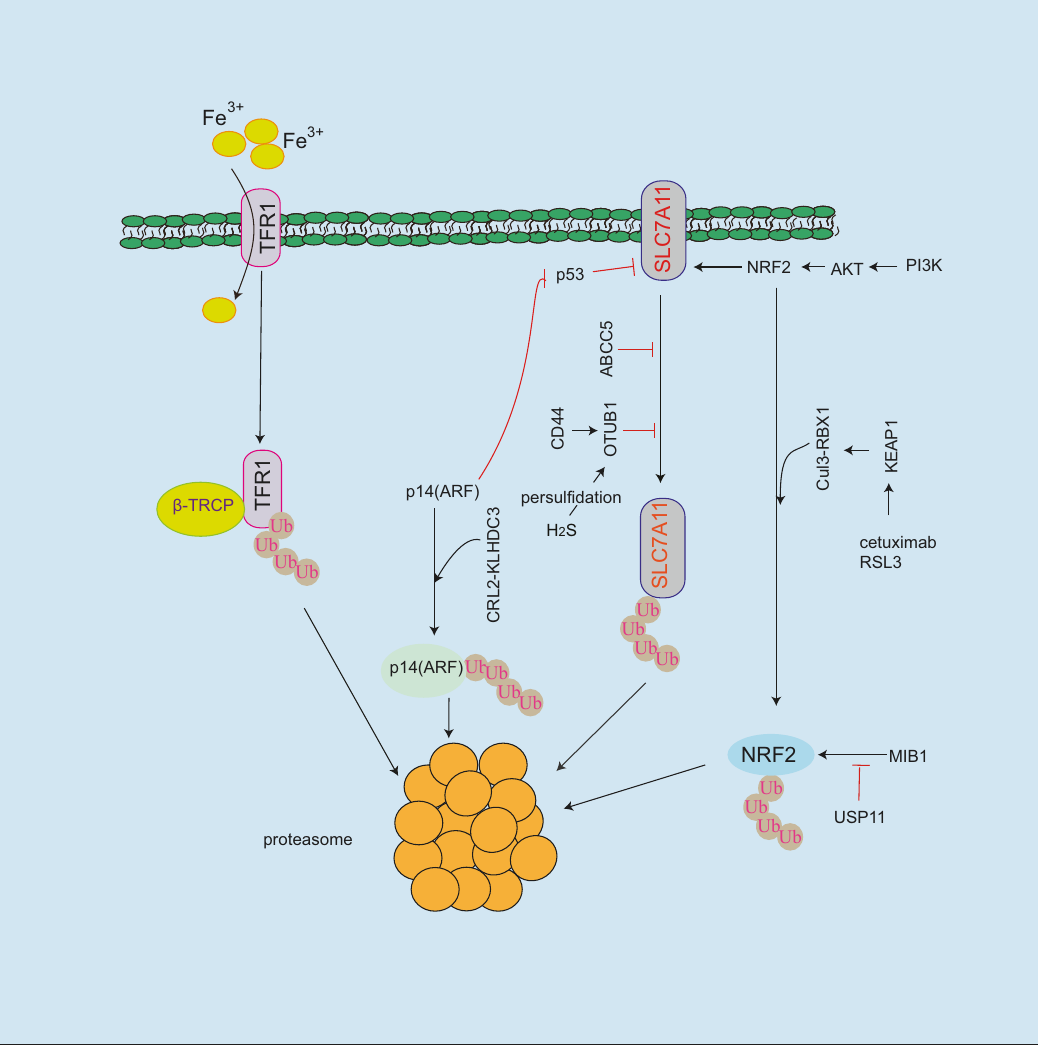
Fig. 2 Regulation of ubiquitination on ferroptosis. Although TFR1 facilitates iron uptake, it will be degraded by β -TRCP ubiquitin ligase leading to ferroptosis resistance. OTUB1 or ABCC5 inhibits SLC7A11 ubiquitination and degradation, and CD44 or H 2 S-mediated persul fi dation of OTUB1 enhances this event. However, it is unclear the mechanism of SLC7A11 degradation in proteasome. MIB1 ubiquitin ligase induces NRF2 ubiquitination and degradation, which is reversed by USP11 deubiquitinating enzyme. Under base condition, the interaction of KEAP1 with NRF2 recruits Cul3-RBX1 ubiquitin ligase to NRF2 for proteasomal-dependent degradation in response to ferroptosis inducers (RSL3, cetuximab). However, in response to oxidative stress, KEAP1 dissociates from NRF2 and increases NRF2 protein stability resulting in ferroptosis resistance. Although p14(ARF)/p53 pathway inhibits SLC7A11 resulting in ferroptosis sensitivity, p14(ARF) is degraded by CRL2-KLHDC3 ubiquitin ligase, which in turn causes ferroptosis